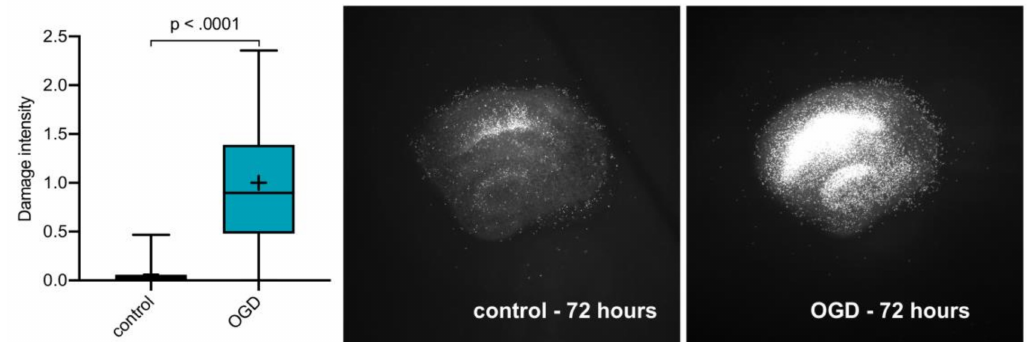
Figure 1. Damage intensity of the control group ( n = 101) vs. oxygen–glucose deprivation (OGD) group ( n = 96). Mann–Whitney U test was used to determine whether our OGD model caused adequate damage. Slice images shown are example slices for control and OGD groups, both at 72 h with typical means for the grey-scale value. Slice images are red-channel-filtered and contrast-enhanced.